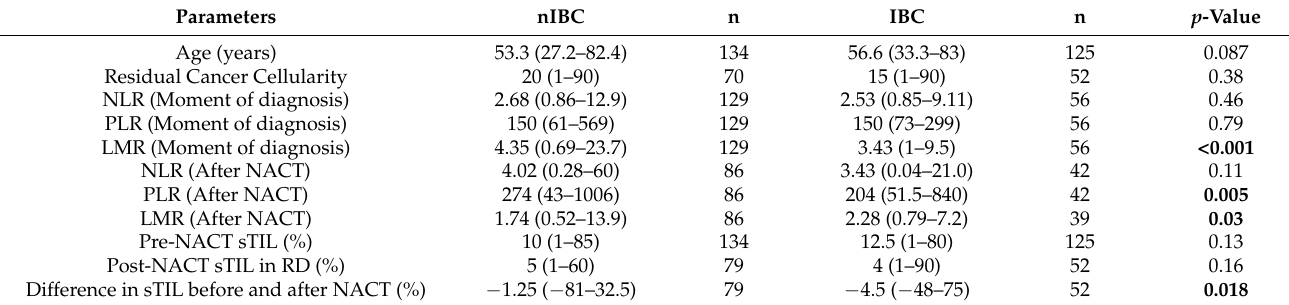
Table 3. Continuous clinicopathological parameters. Comparison between nIBC and IBC was done using Wilcoxon signed rank test. nIBC: non-inflammatory breast cancer, IBC: inflammatory breast cancer, RD: residual disease, NLR: neutrophil- lymphocyte ratio, PLR: platelet-lymphocyte ratio, LMR: lymphocyte-monocyte ratio and, sTIL: stromal tumour infiltrating lymphocytes, NACT: neo-adjuvant chemotherapy. Bold values denote statistical significance at the p < 0.05